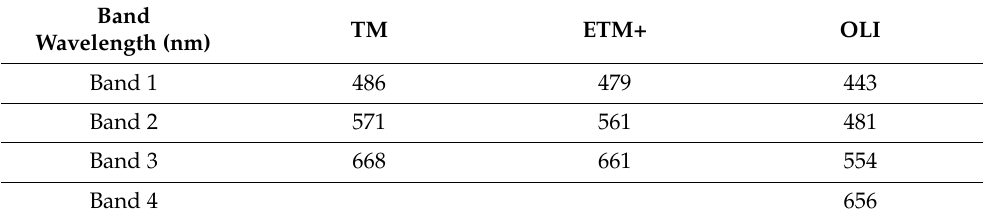
Figure 3. Scatter plots of before and after the replacement of the estimated Z SD of Landsat OLI data with a 1:1 fit line. Table 3. The representative wavelength of TM, ETM+ and OLI visible bands.